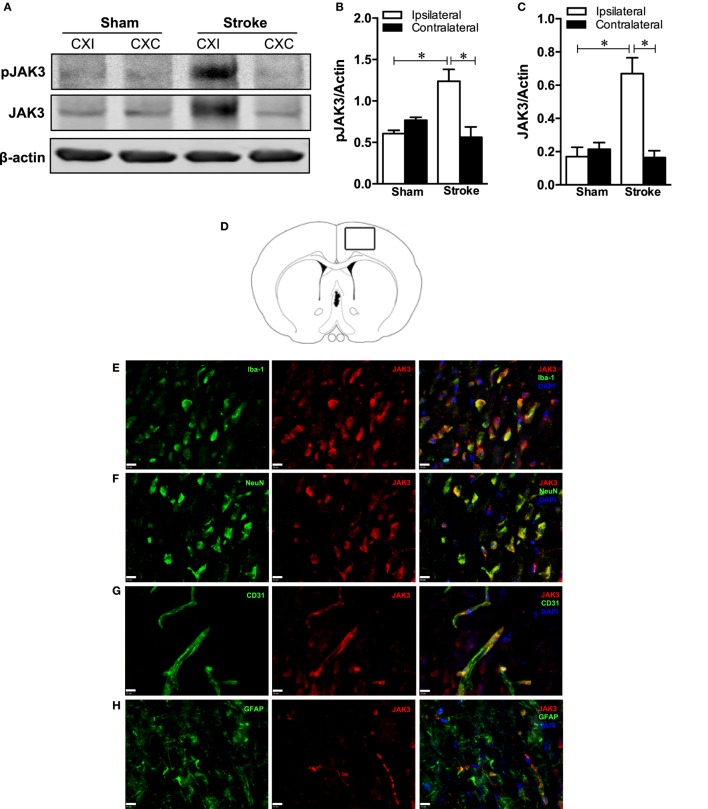
(A) Representative Western blots depicting phosphorylated JAK3 (pJAK3), total JAK3, and corresponding β-actin levels in the ipsilateral (CXI) versus the contralateral (CXC) cortex at 24 h in sham and mice subjected to permanent middle cerebral artery occlusion (pMCAO). (B,C) Quantified pJAK3 and JAK3 values normalized to β-actin in the cortex of sham and mice subjected to stroke. Both pJAK3 and JAK3 are significantly increased in the ipsilateral cortex of stroked animals (*P < 0.05 and **P < 0.01 with respect to sham ipsilateral/contralateral and stroke contralateral; sham, n = 5; stroke, n = 13). Data were analyzed using a two-way ANOVA (ipsilateral/contralateral or sham/stroke) with Bonferroni post-test. (D) Diagram showing peri-infarct brain region from which images were taken (n = 3). Scale bar is 10 µm, and magnification is 60×. (E) JAK3 colocalized with microglia/macrophages labeled with Iba-1. (F) JAK3 colocalized with neurons labeled with NeuN. (G) JAK3 colocalized with endothelial cells labeled with CD31. (H) JAK3 is not colocalized with astrocytes labeled with GFAP.